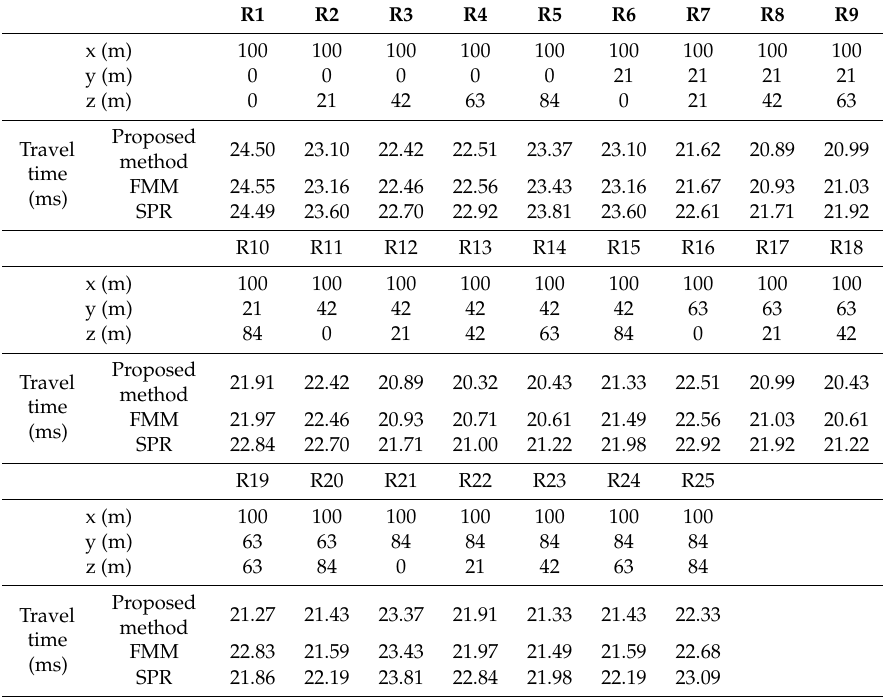
Figure 11. The relative error of the arrival time of the three methods compared to the analysis solution.